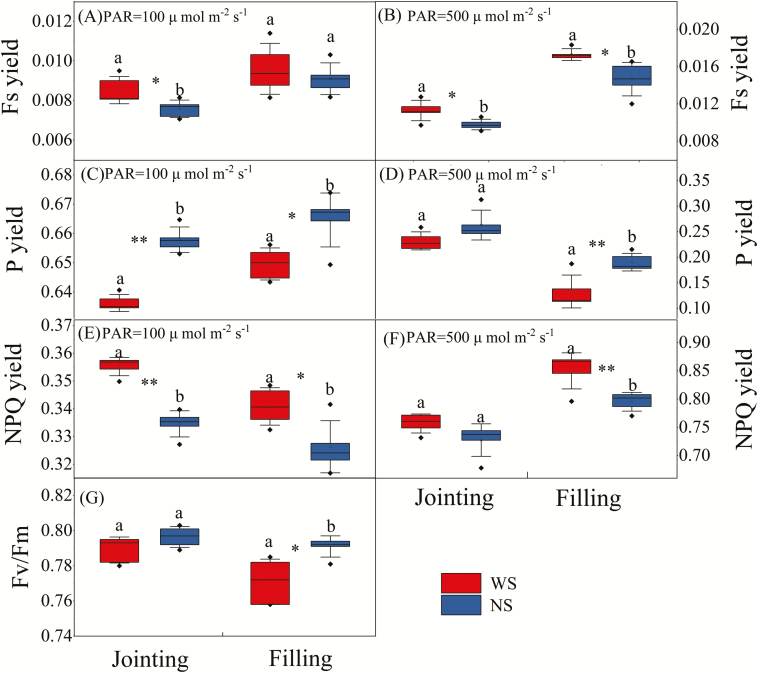
Comparisons of Fv/Fm, Fs yield, P yield, and NPQ yield in leaves of summer maize between the water stress (WS) and non-water stress (NS) treatments at the jointing stage (45 days after sowing) and filling stage (90 days after sowing) under (A, C, E) low light (PAR=100 μmol m–2 s–1) and (B, D, F) intermediate light (PAR=500 μmol m–2 s–1) conditions. Data are based on measurements made on five plants in each treatment. The top and bottom of the box represent the quartiles; the horizontal line in the box represents the median value; the whiskers represent ±1 SD. Mean values in the two treatments were compared by the t-test; different letters indicate significant differences: *p <0.05, **p<0.01.